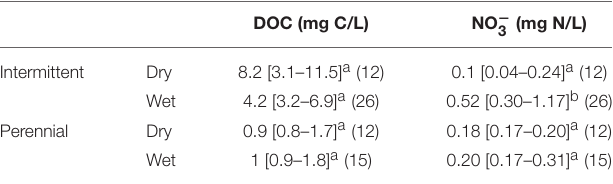
TABLE 1 | Median [25th, 75th percentiles] of weighted concentration ( ˆ C ) for dissolved organic carbon (DOC) and nitrate (N-NO − 3 ) for individual storms occurring at the intermittent stream (Fuirosos, period 1999–2002) and the perennial stream (Font del Regàs, period